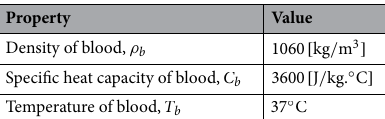
Property Value Density of blood, ρ